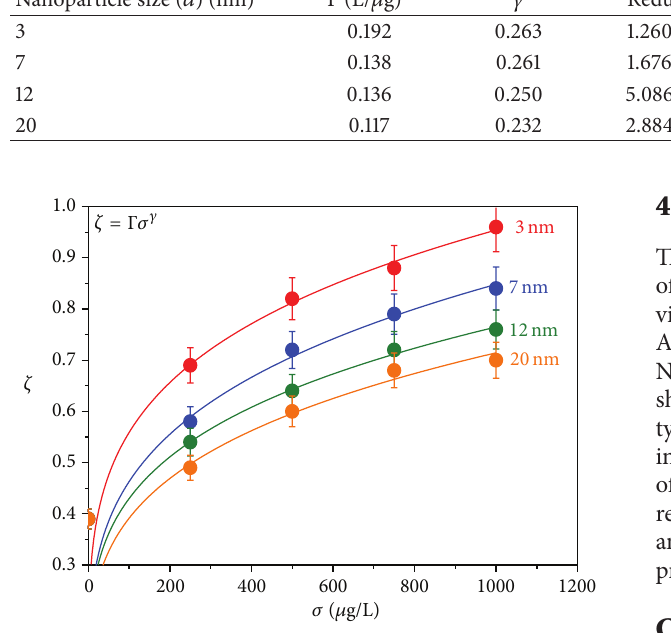
Figure 6: Variation of the ratio of nuclear volume ( 𝑉 𝑛 ) to cellular volume ( 𝑉 𝑐 ) in CS tissue layout ( 𝜁 ) of Mystus tengara with increasing ZnS nanoparticle concentration ( 𝜎 ) for a fixed exposure time ( 𝑡 = 60 days) keeping nanoparticle size ( 𝑑 ) as a